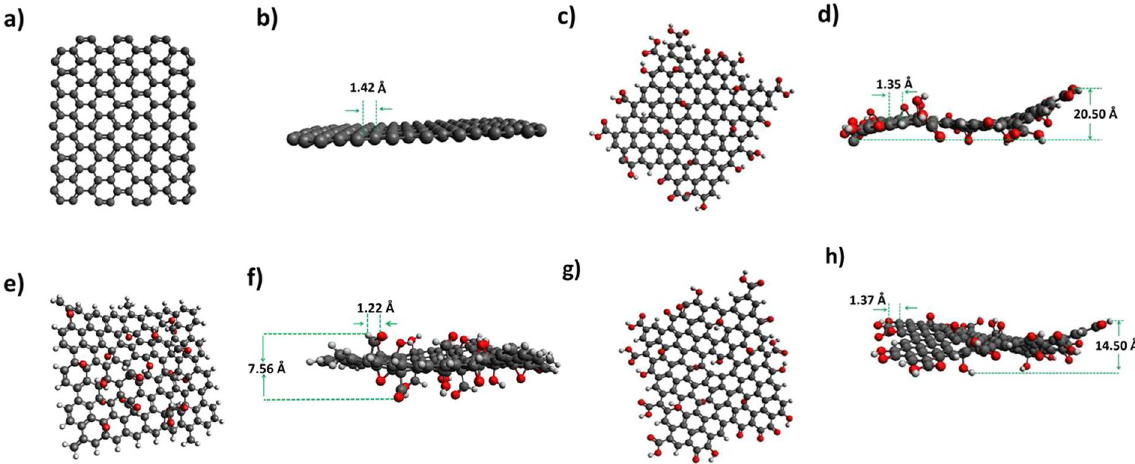
Figure 8. Optimized geometries for a 7 × 7 nanoflakes of graphene (top view ( a ); side view ( b )), GO with comparable number of functional groups along the edges as well as in the basal plane (top view ( c ); side view ( d )), GO with functional groups primarily in the basal plane and edge passivation using H (top view ( e ); side view ( f )), rGO with a number of functional groups removed from the GO nanoflake with functional groups along the edges as well as in the basal plane (top view ( g ); side view ( h )). Various distances are marked to provide an idea regarding the